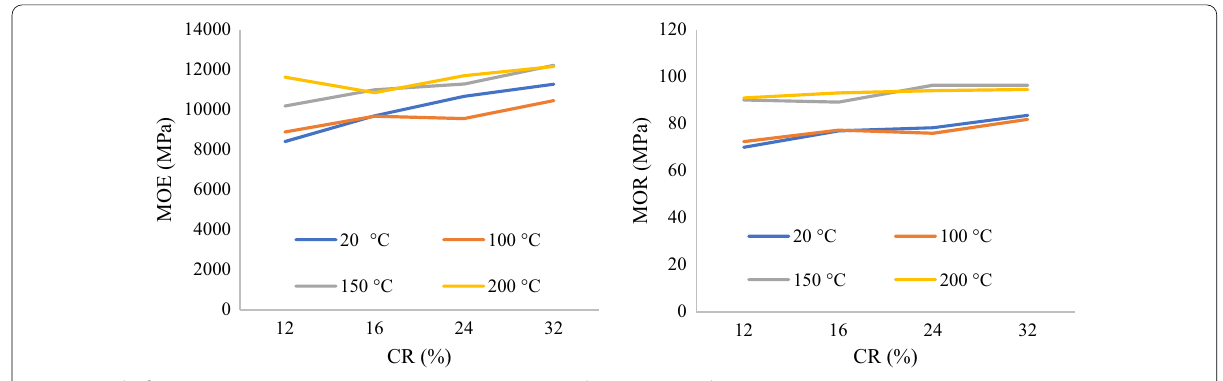
Fig. 6 Results from [25] comparing various pressing temperatures and CR to MOE and